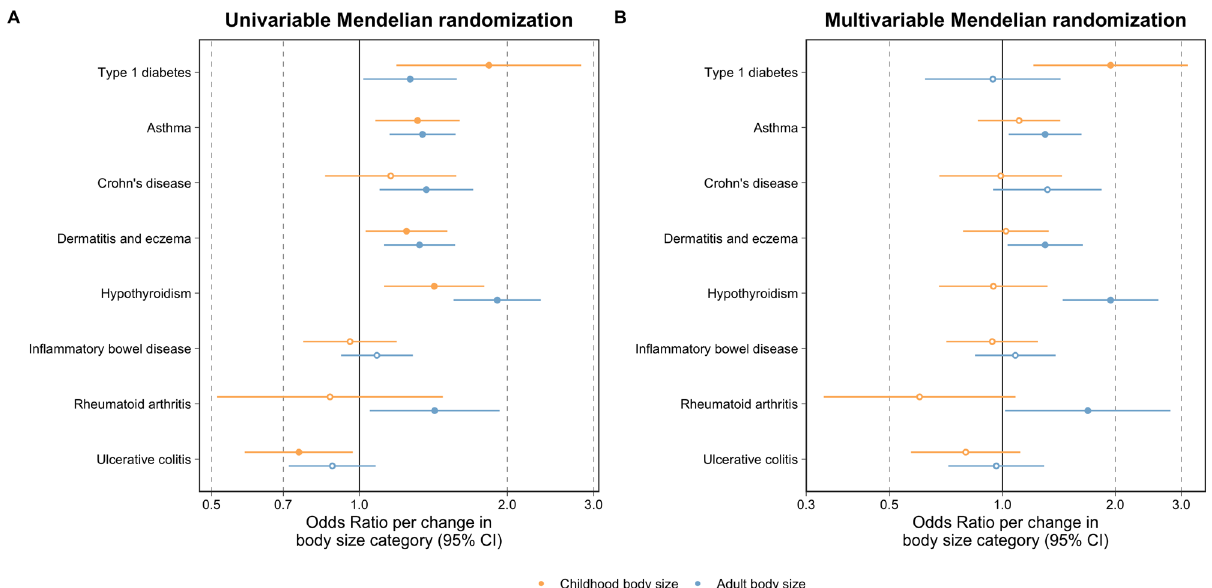
Fig. 4 Forest plots comparing the univariable and multivariable Mendelian randomisation estimates of childhood body size on type 1 diabetes risk and seven chronic immune disease outcomes. A The univariable Mendelian randomisation (MR) estimates between childhood (yellow) and adult (blue) body size ( n = 453,169) on the risk of chronic immune disease outcomes (see Supplementary Data 1 for sample sizes) and B their corresponding multivariable MR estimates. The type 1 diabetes estimates were based on the analysis using data from Crouch et al. (2021) ( n = 173,981). Odds ratios are per change in body size category. 95% CI 95% con fi dence interval. Central estimates are illustrated as circles which were fi lled when con fi dence intervals did not overlap with the null. The data underlying this fi gure can be found in Supplementary Data 13 and 17. Multiple testing comparisons for estimates in this fi gure were accounted for by calculating false discovery rates as reported in Supplementary Data